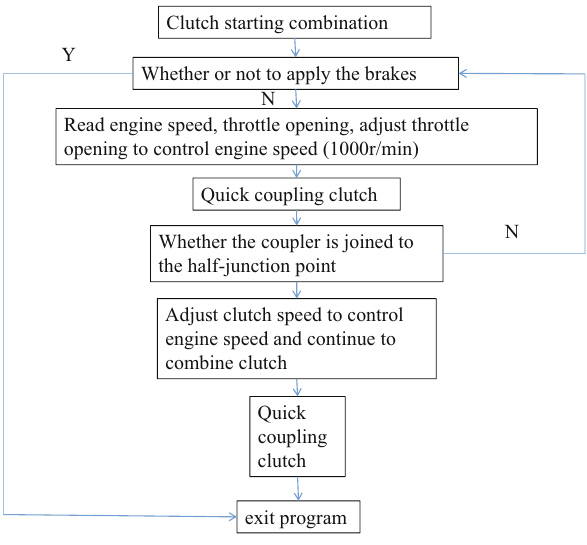
Figure 1: Vehicle starting current variable clutch